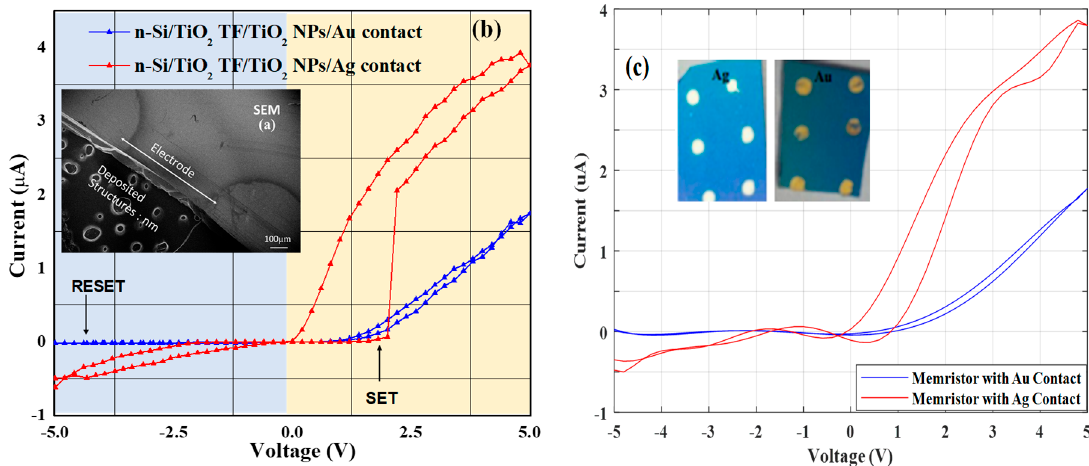
Figure 3. A multilayer memristor devices with its ( a ) sample morphology SEM image ( b ) I–V characteristics under different sweeping voltages and ( c ) statistical fit I–V curve.